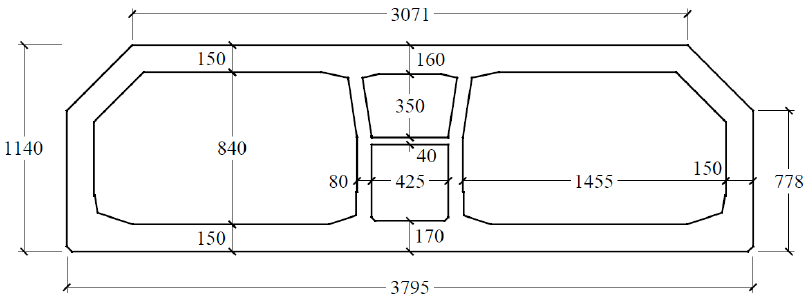
Figure 4. Cross-sectional geometry of the HZMB immersed tunnel.